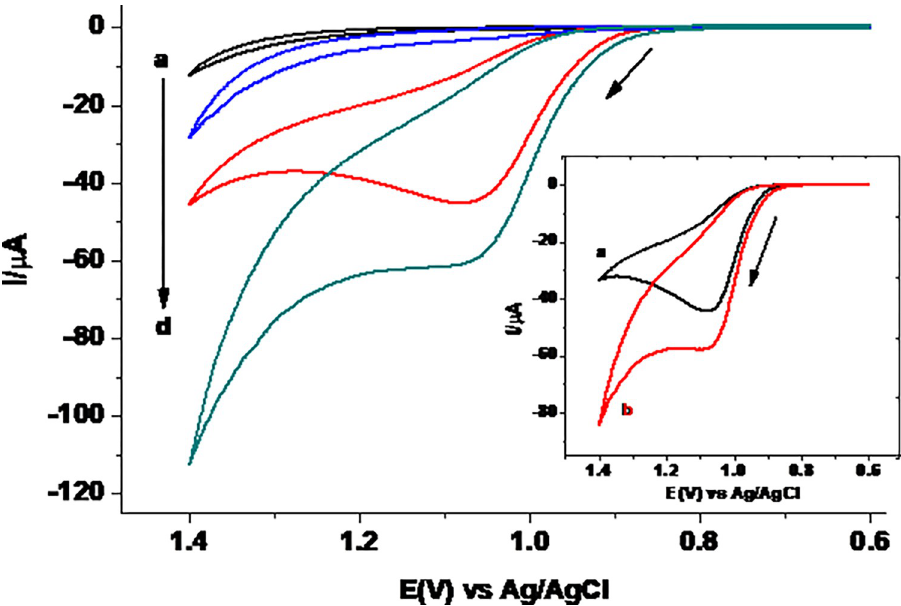
Fig 4. Cyclic voltammograms of UCPE (a & c) and MCPE (b & d) in pH 7.0 PBS in the absence (a & b) and presence (c and d) of 0.5 mM TP at scan rate of 100 mV s -1 . Inset: Corrected for blank cyclic voltammograms of (a) UCPE and (b)